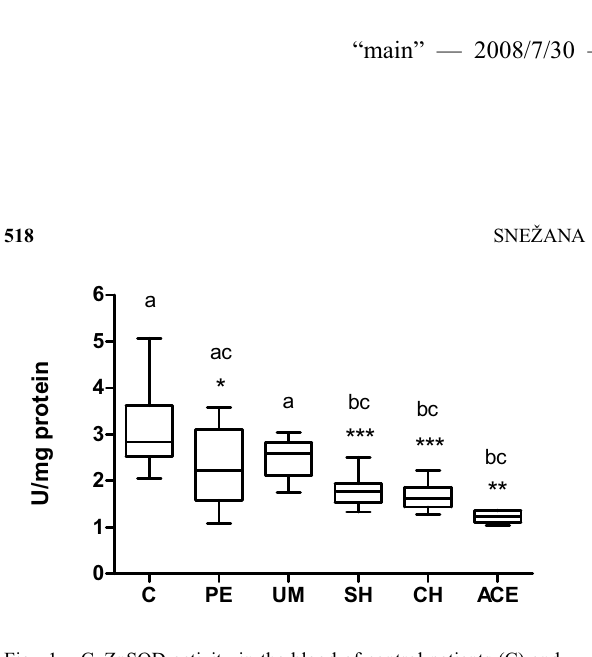
Fig. 1 – CuZnSOD activity in the blood of control patients (C) and patients diagnosed with: polypus endometrii (PE), uterus myomatosus (UM), simple hyperplasia (SH), complex hyperplasia (CH) and ade- nocarcinoma endometrii (ACE). Mean SOD activities ( ± SD) are rep- resented by the box; medians are plotted inside the box; the whiskers extend to the 5 th and 95 th percentiles. Values which are not desig- nated by the same letter (a, b, c) are significantly different (p < 0 . 05). Values marked with asterisk(s) are significantly different (*p < 0 . 05, **p < 0 . 01, ***p < 0 . 001) than the control (Peji´c et al. 2006). Fig. 2 – A. Relative protein contents. Example of Western blot im-